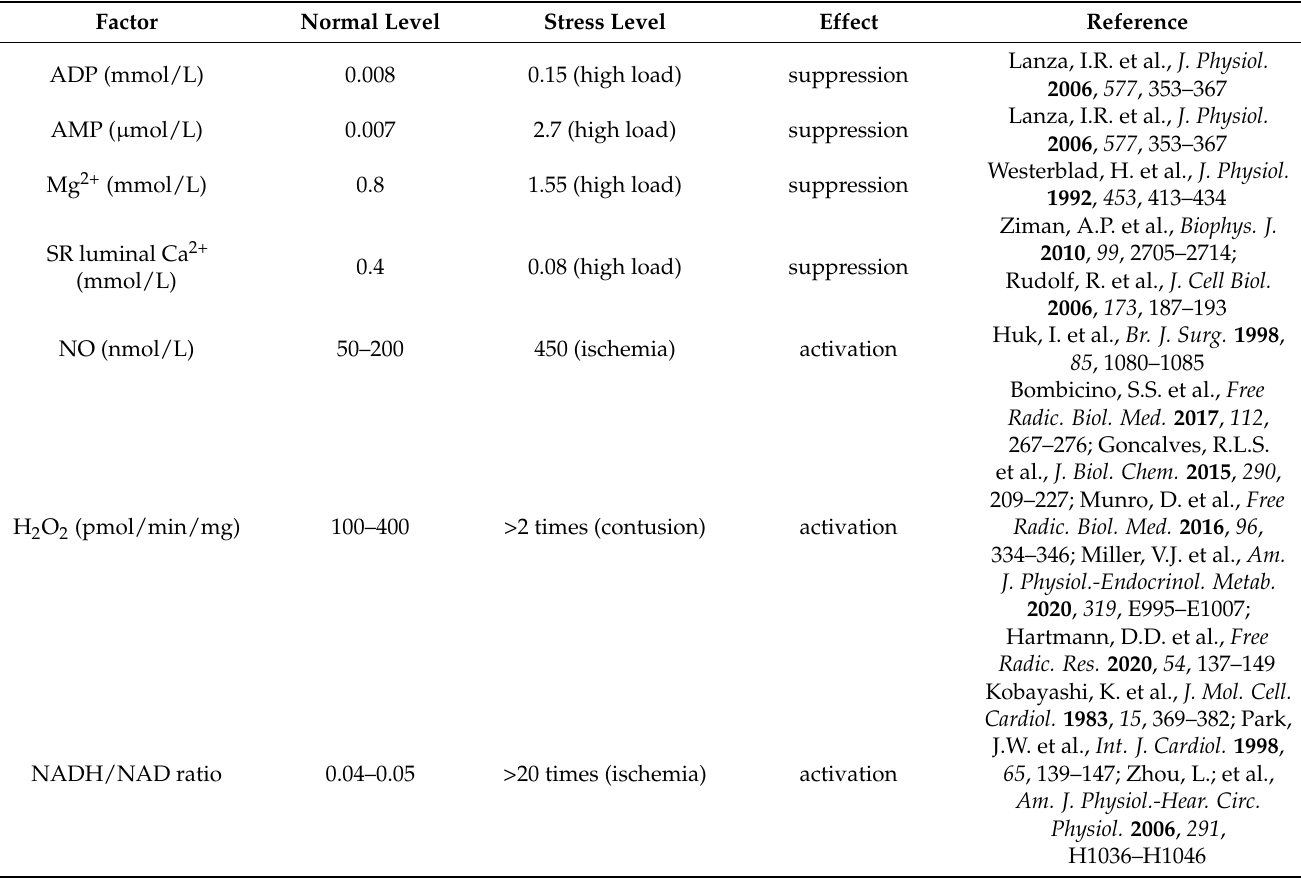
Table 1. The effects of changes in intracellular factors on the activity of the ryanodine receptor in muscle.